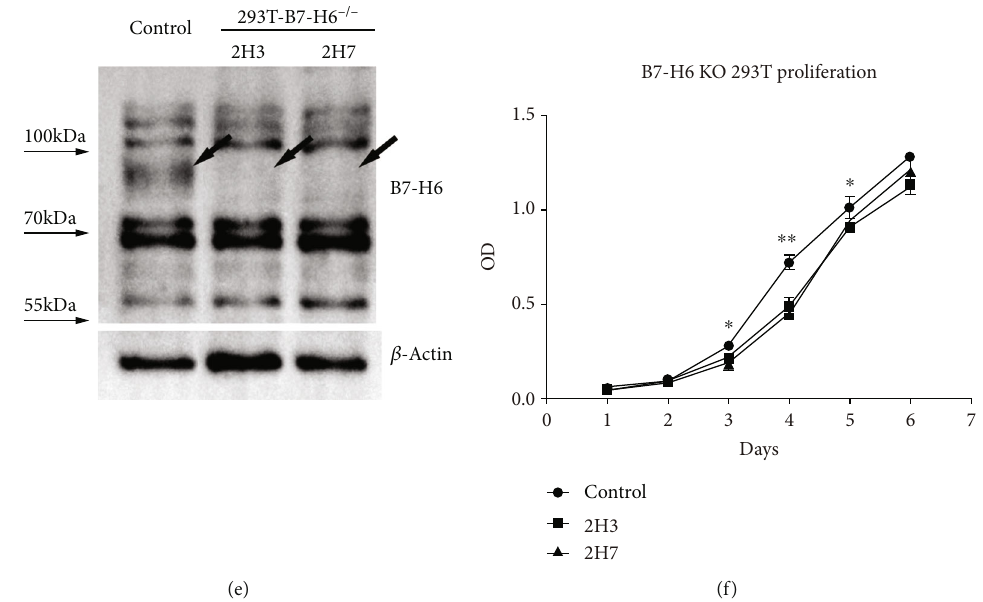
Figure 3: Impacts of B7-H6 depletion in GSLCs and 293T. (a) Cell proliferation of GSLCs transfected with siR-NC, siR-708, or siR-993 was measured by CCK-8 triplicated on 0, 48, 72, and 96h. (b) Cell signaling proteins Akt and ERK were analyzed by WB in GSLCs transfected with siR-NC, siR-708, or siR-993, and housekeeping gene GAPDH was blotted as control. (c) mRNA expression of c-Myc was evaluated by RT-PCR in U87, GSLCs, and GSLCs transfected with siR-NC, siR-708, or siR-993, respectively ( n = 3 ). (d) Pearson correlation analysis was performed between the mRNA expression of B7-H6 and c-Myc base on CGGA mRNA-Seq database. (e) B7-H6 expression was analyzed by western blot in control and B7-H6 KO 293T cells. Arrows pointed out the speci fi c band of B7-H6. (f) Cell proliferation assay was performed on control and B7-H6 KO 293T cells. 2H3 and 2H7 were two di ff erent clones of B7-H6 de fi cient 293T cells ( n = 3 ). Data of (a), (c), and (f) were mean ± SD . ∗ P < 0 : 05 , ∗∗ P < 0 : 01 , and ∗∗∗ P < 0 : 005